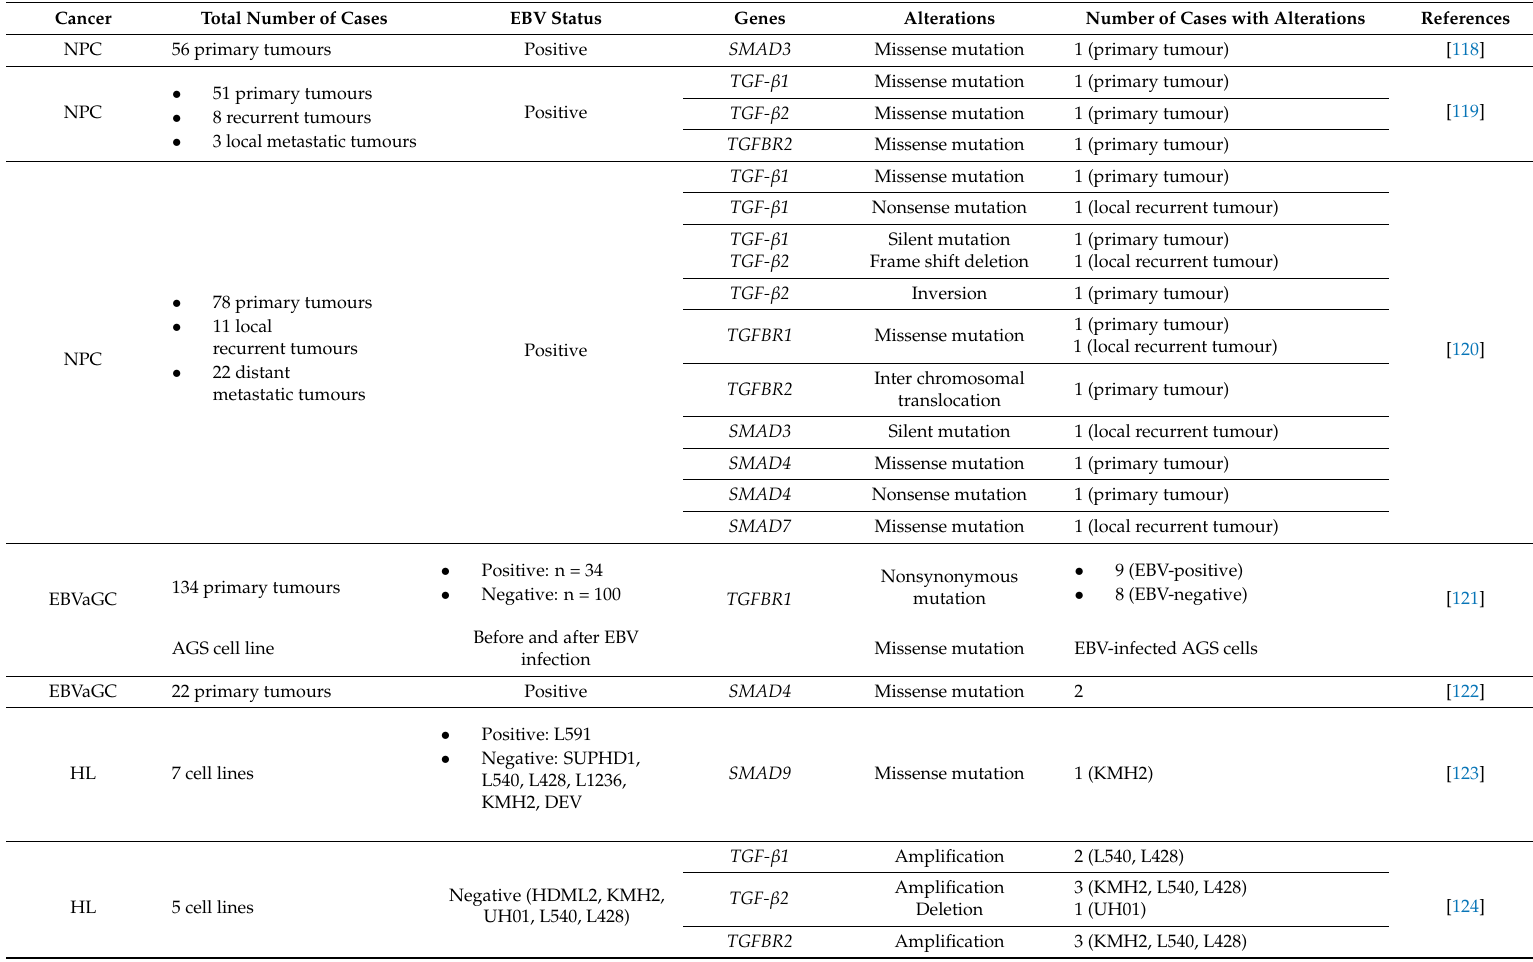
Table 2. Genetic alterations of TGF- β pathway components in EBV-associated cancers identified by next-generation sequencing.